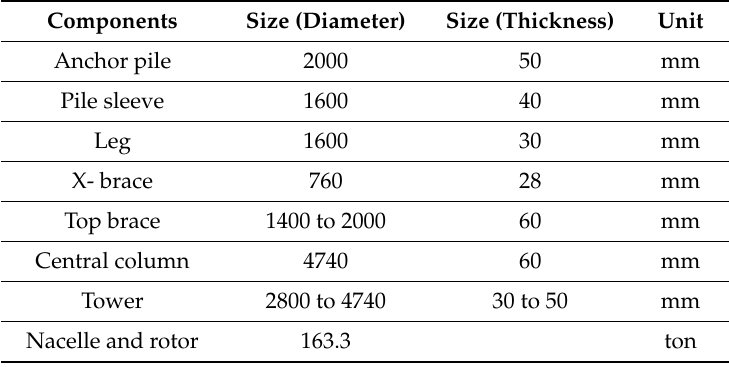
Table 4. Component geometries of the support